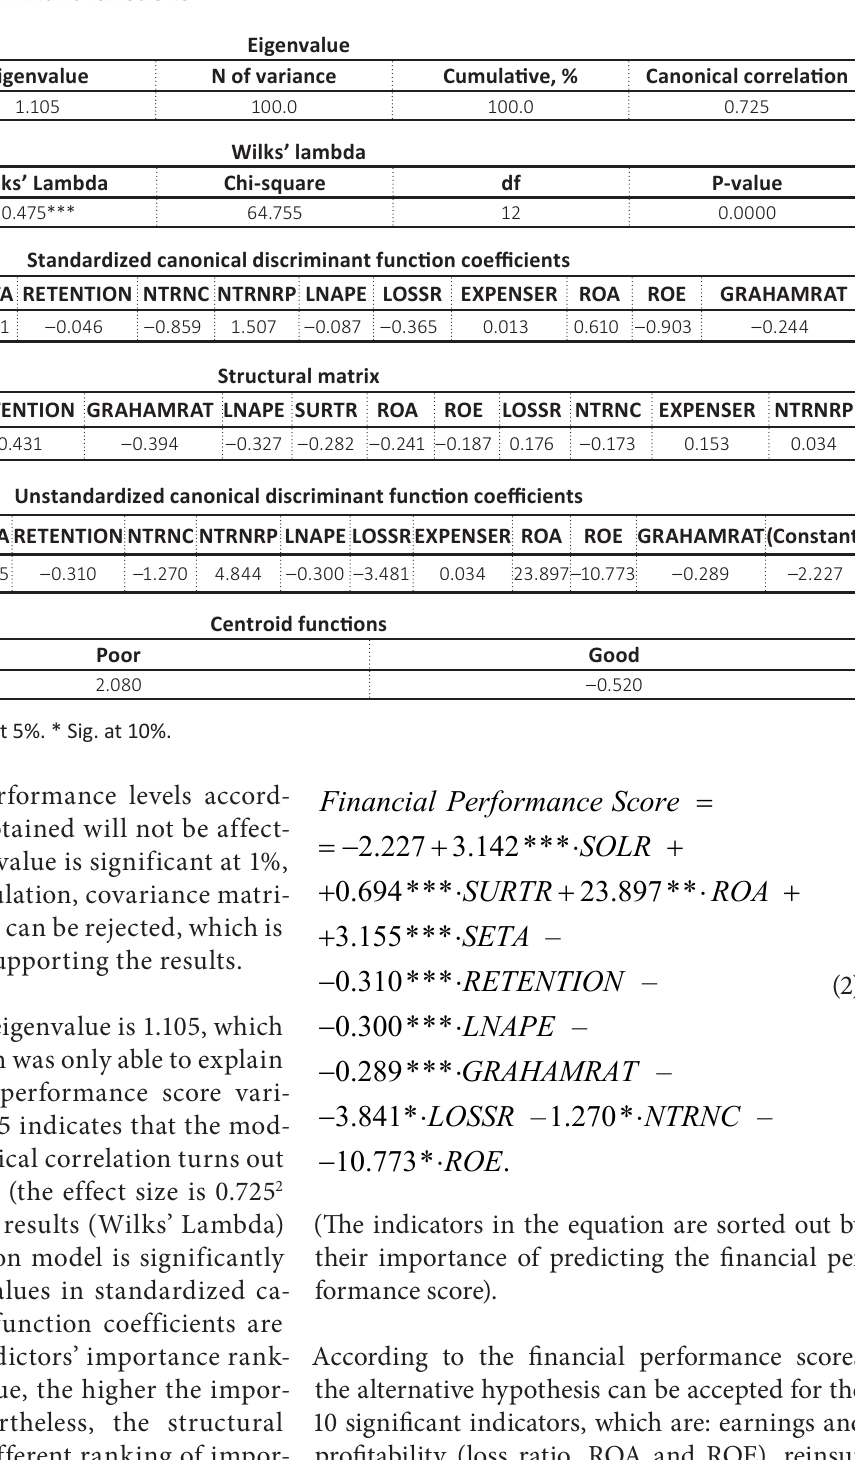
Table 5. Canonical discriminant